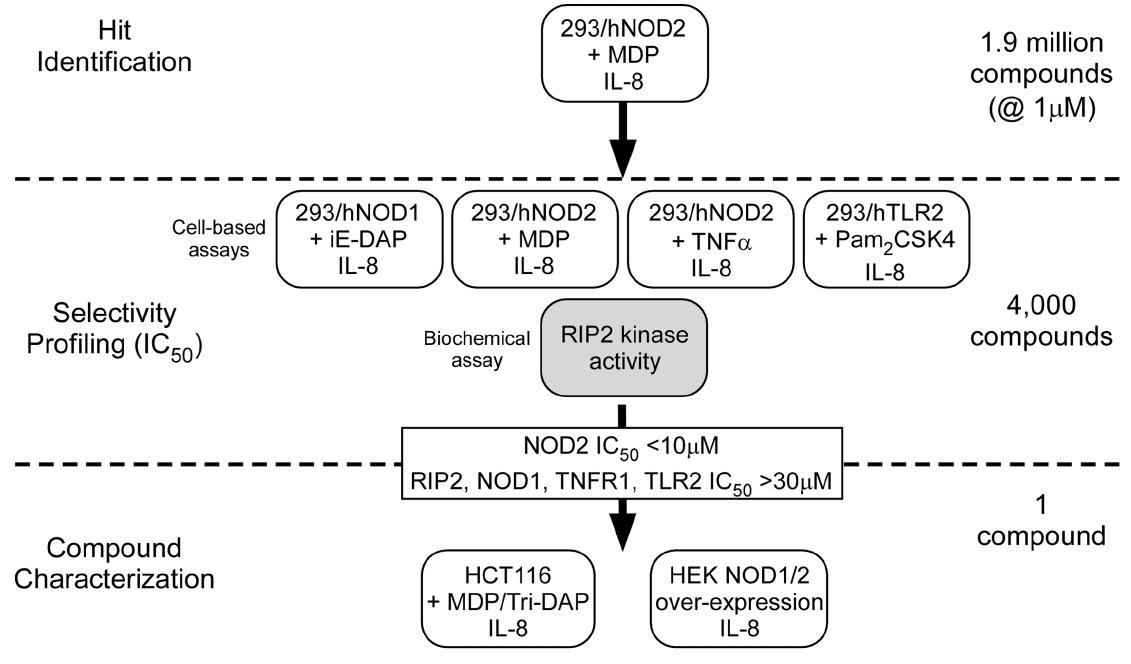
Figure 1. Cell-based screening scheme used to identify selective NOD2 inhibitors. The compound collection was screened for inhibitors of MDP-induced IL-8 secretion in 293/hNOD2 stable cells. Active inhibitors were then tested for selectivity against IL-8 induced by alternative pathways including NOD1, TNFR1 and TLR2 as well as for direct inhibitors of RIP2 kinase. The activity of selective NOD2 inhibitors was then confirmed in cells expressing NOD2 endogenously and against agonist-independent NOD2